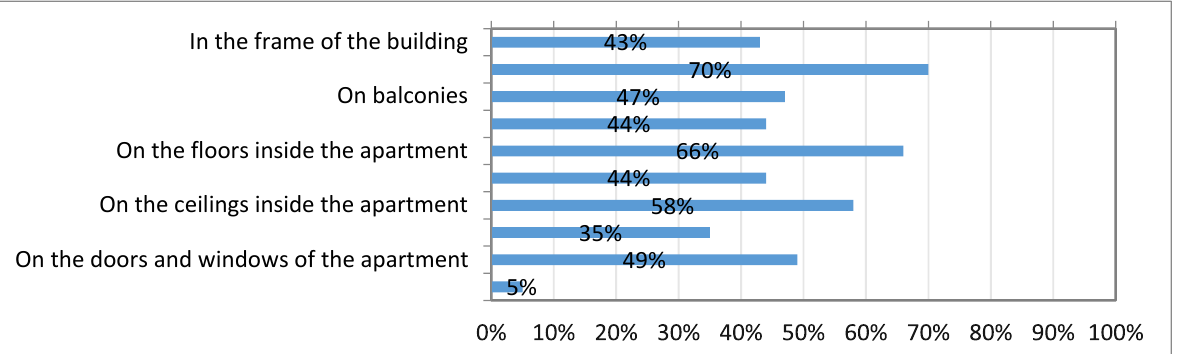
Figure 19. The places where the use of wood is most desired.